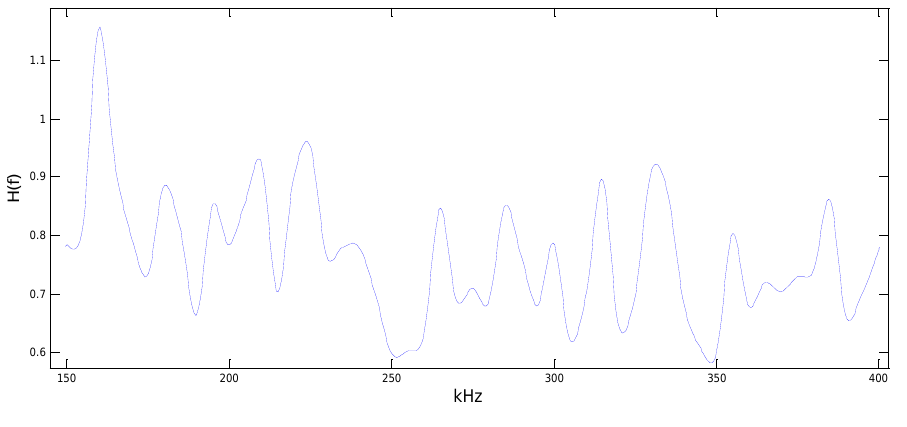
Figure 9. The energy space distribution diagram around the stiffener.